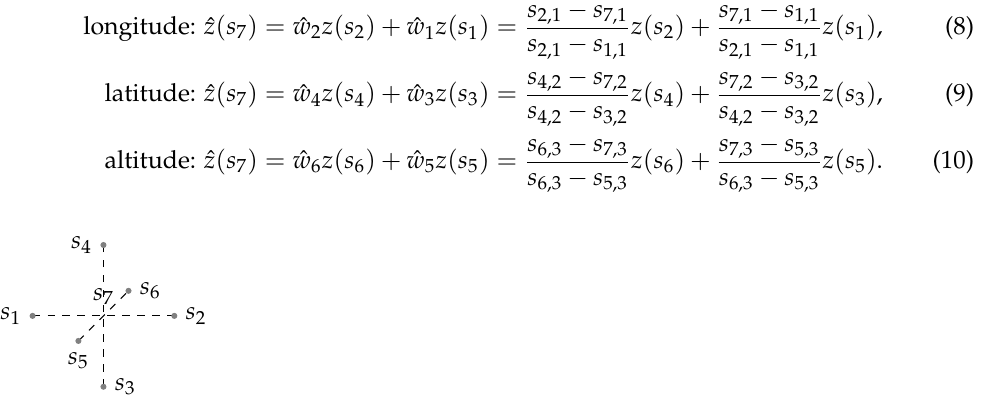
Figure 9. LOOCV for linear interpolation with six nearest